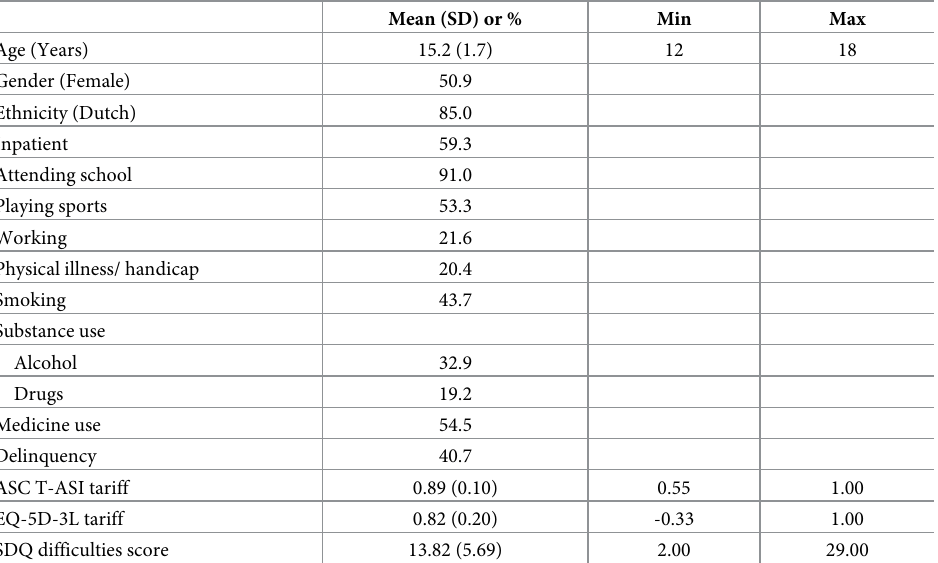
Table 2. Sample characteristics ( n = 167) a .